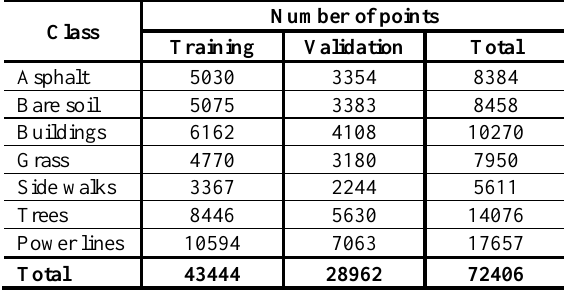
Table 2. Total number of points per class, part used for the training and part used for the